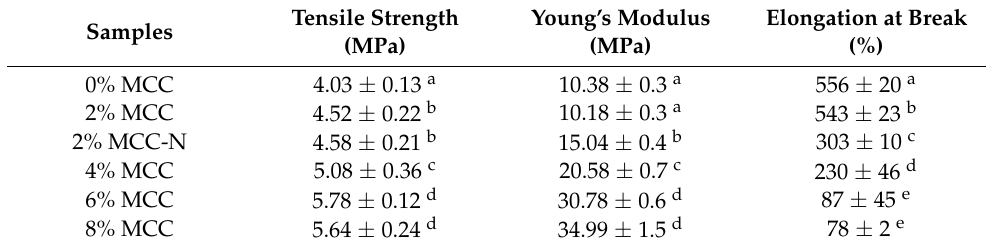
Table 2. Mechanical properties of PBAT/TPS/MCC